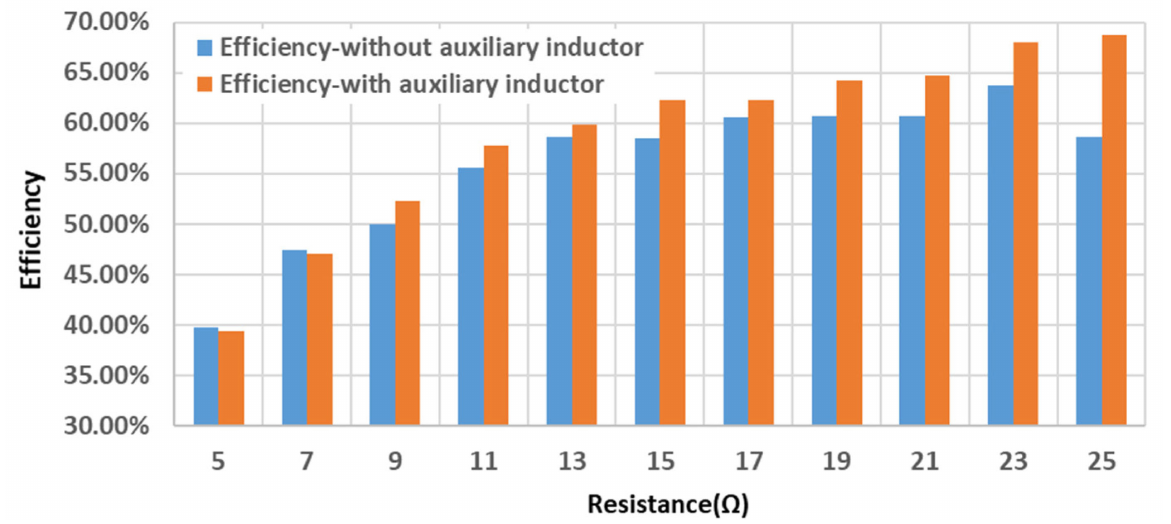
Figure 23. The comparison of the overall system efficiency with and without the auxiliary